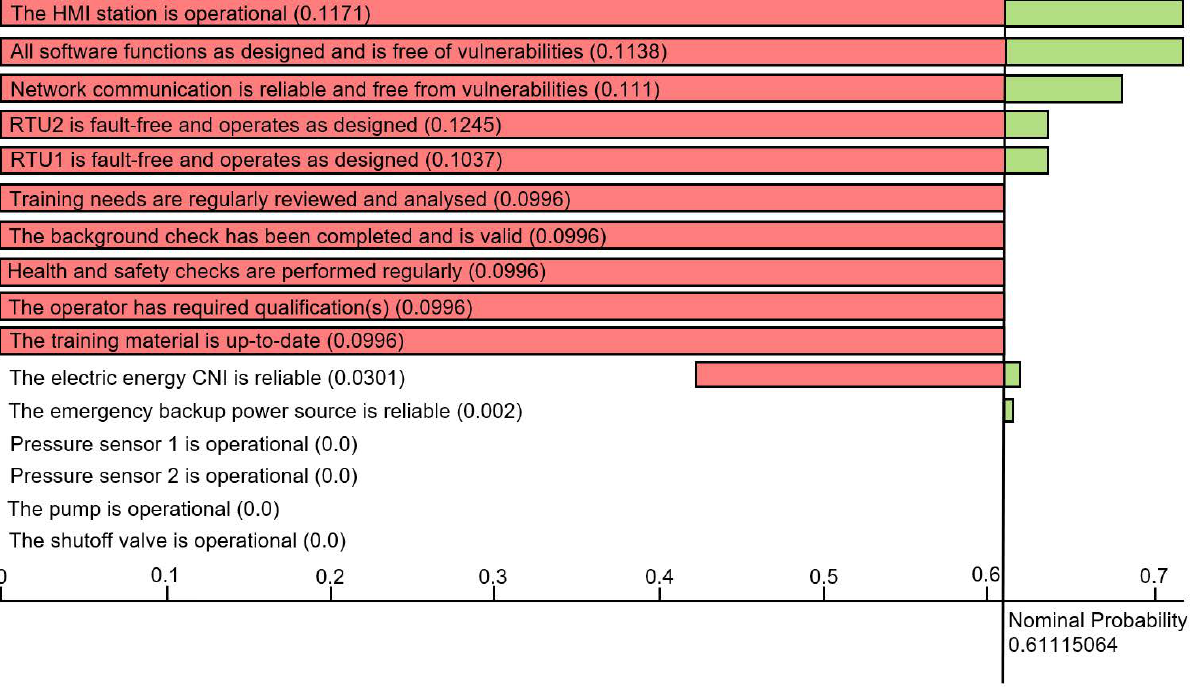
Figure 12. Three-Point Sensitivity Graph for the Water Distribution SCADA System with Counter-